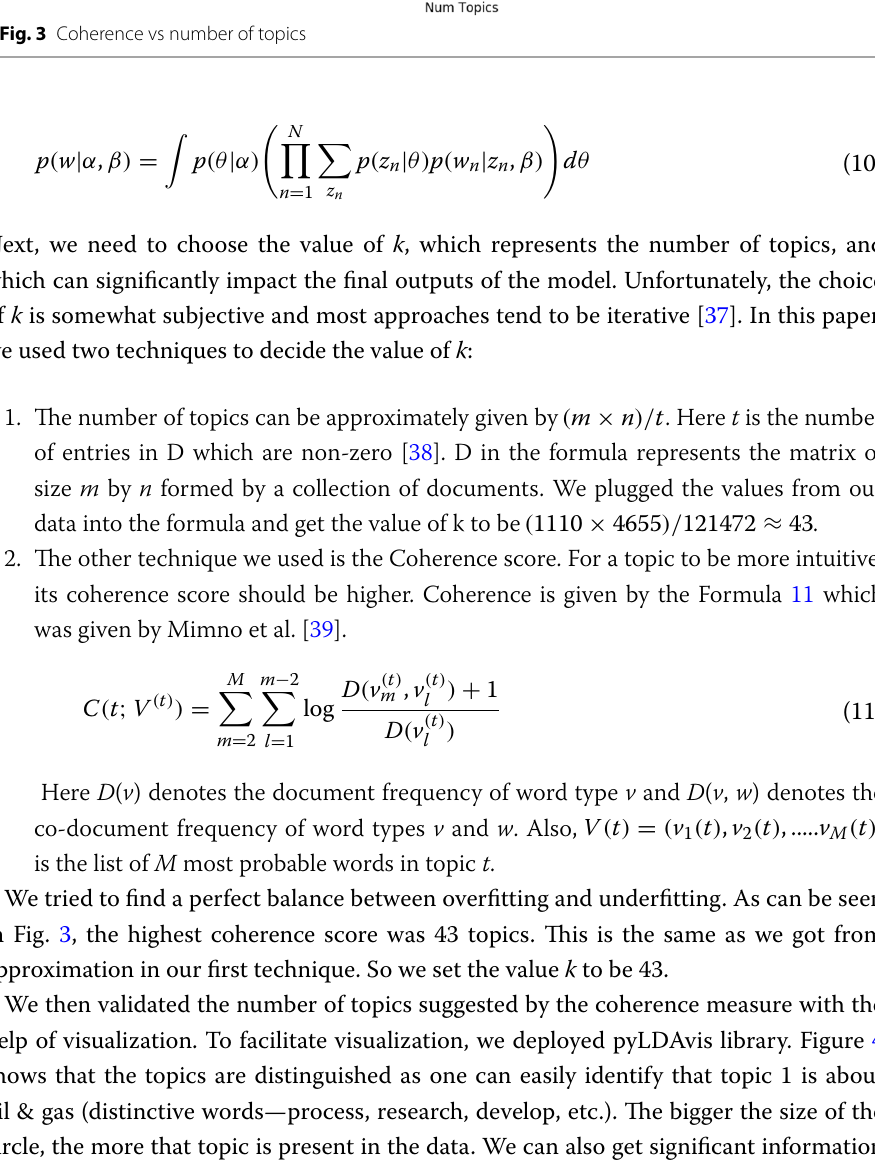
Fig. 3 Coherence vs number of